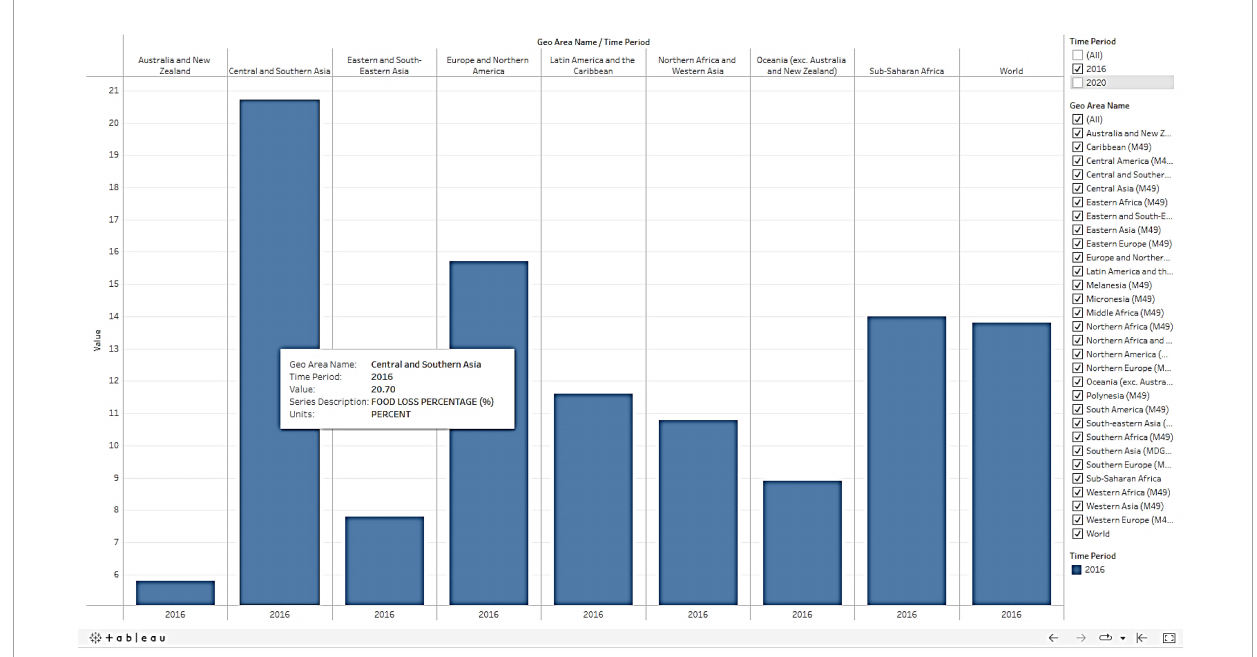
FIGURE1 Food loss percentage in Central and South Asia (https://www.fao.org/sustainable-development-goals/indicators/1231/en/).